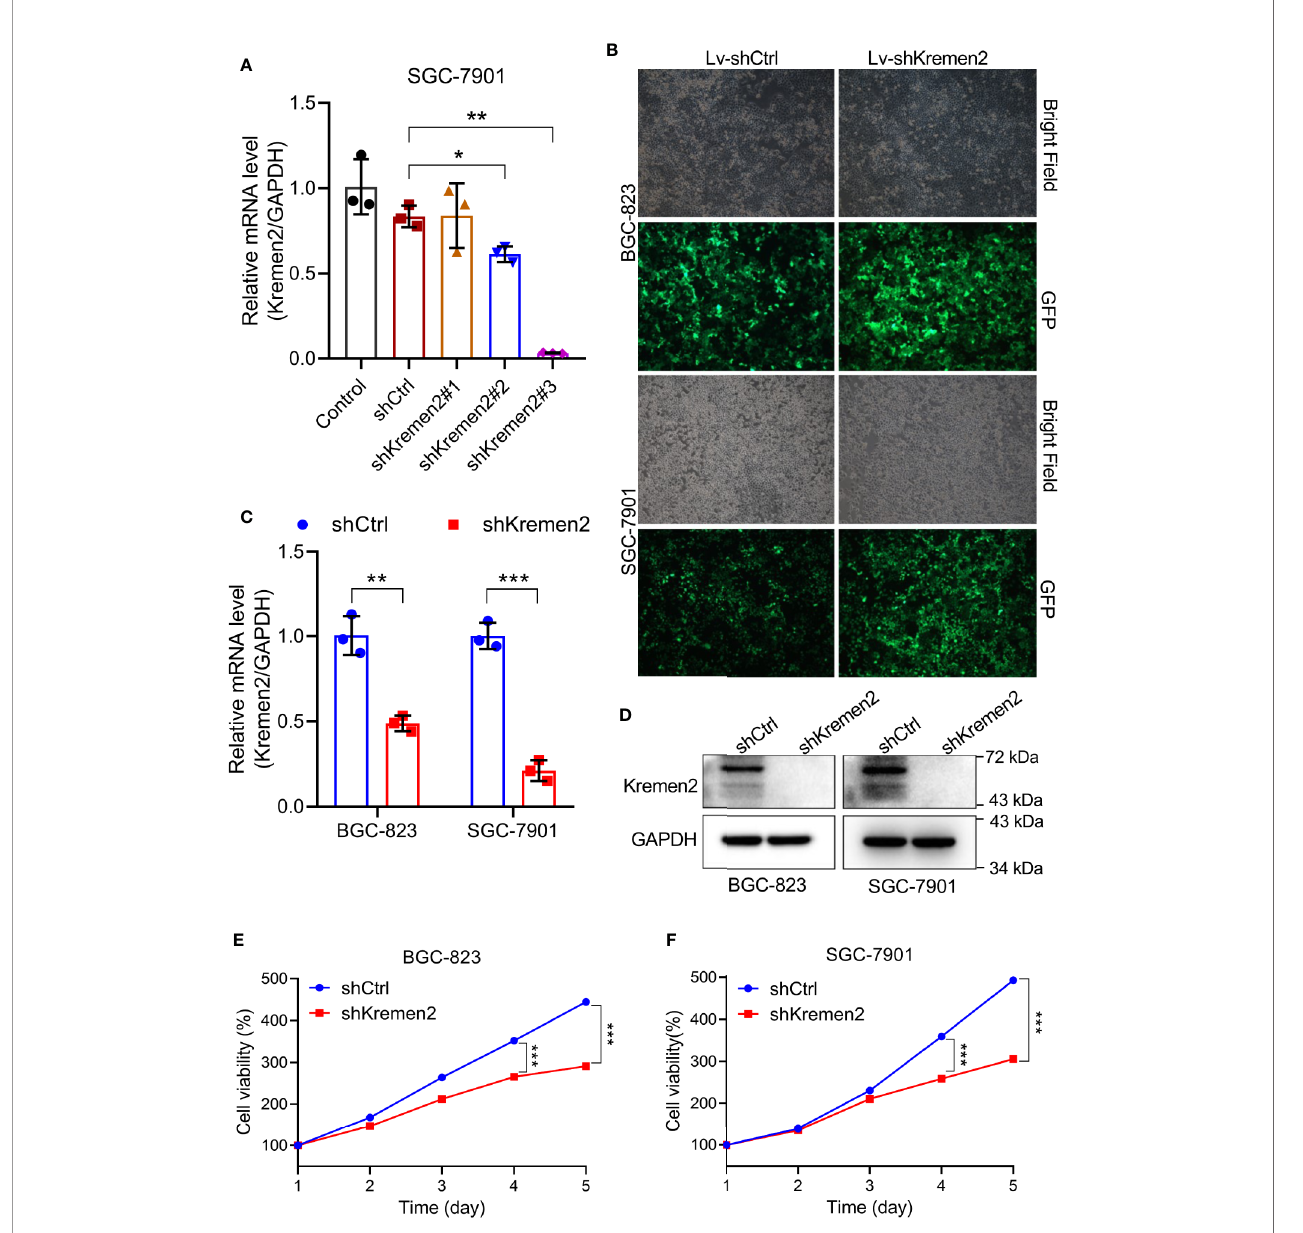
FIGURE 2 | Kremen2 knockdown suppressed cell survival of GC in vitro . (A) SGC-7901 cells were transfected with Lenti-shKremen2 (#1, #2 and #3) or Lenti- shCtrl, and the mRNA level of Kremen2 was measured by qRT-PCR. (B) Infection ef fi ciency of Lenti-shKremen2_#3 was above 80%. (C) mRNA levels of Kremen2 in BGC-823 and SGC-7901 cells after transfection with Lenti-shKremen2. (D) Protein levels of Kremen2 in BGC-823 and SGC-7901 cells after transfection with Lenti- shKremen2. (E) BGC-823 cell survival after Kremen2 knockdown was detected using MTT assay. (F) SGC-7901 cell survival after Kremen2 knockdown was detected using MTT assay. * P < 0.05; ** P < 0.01; *** P <